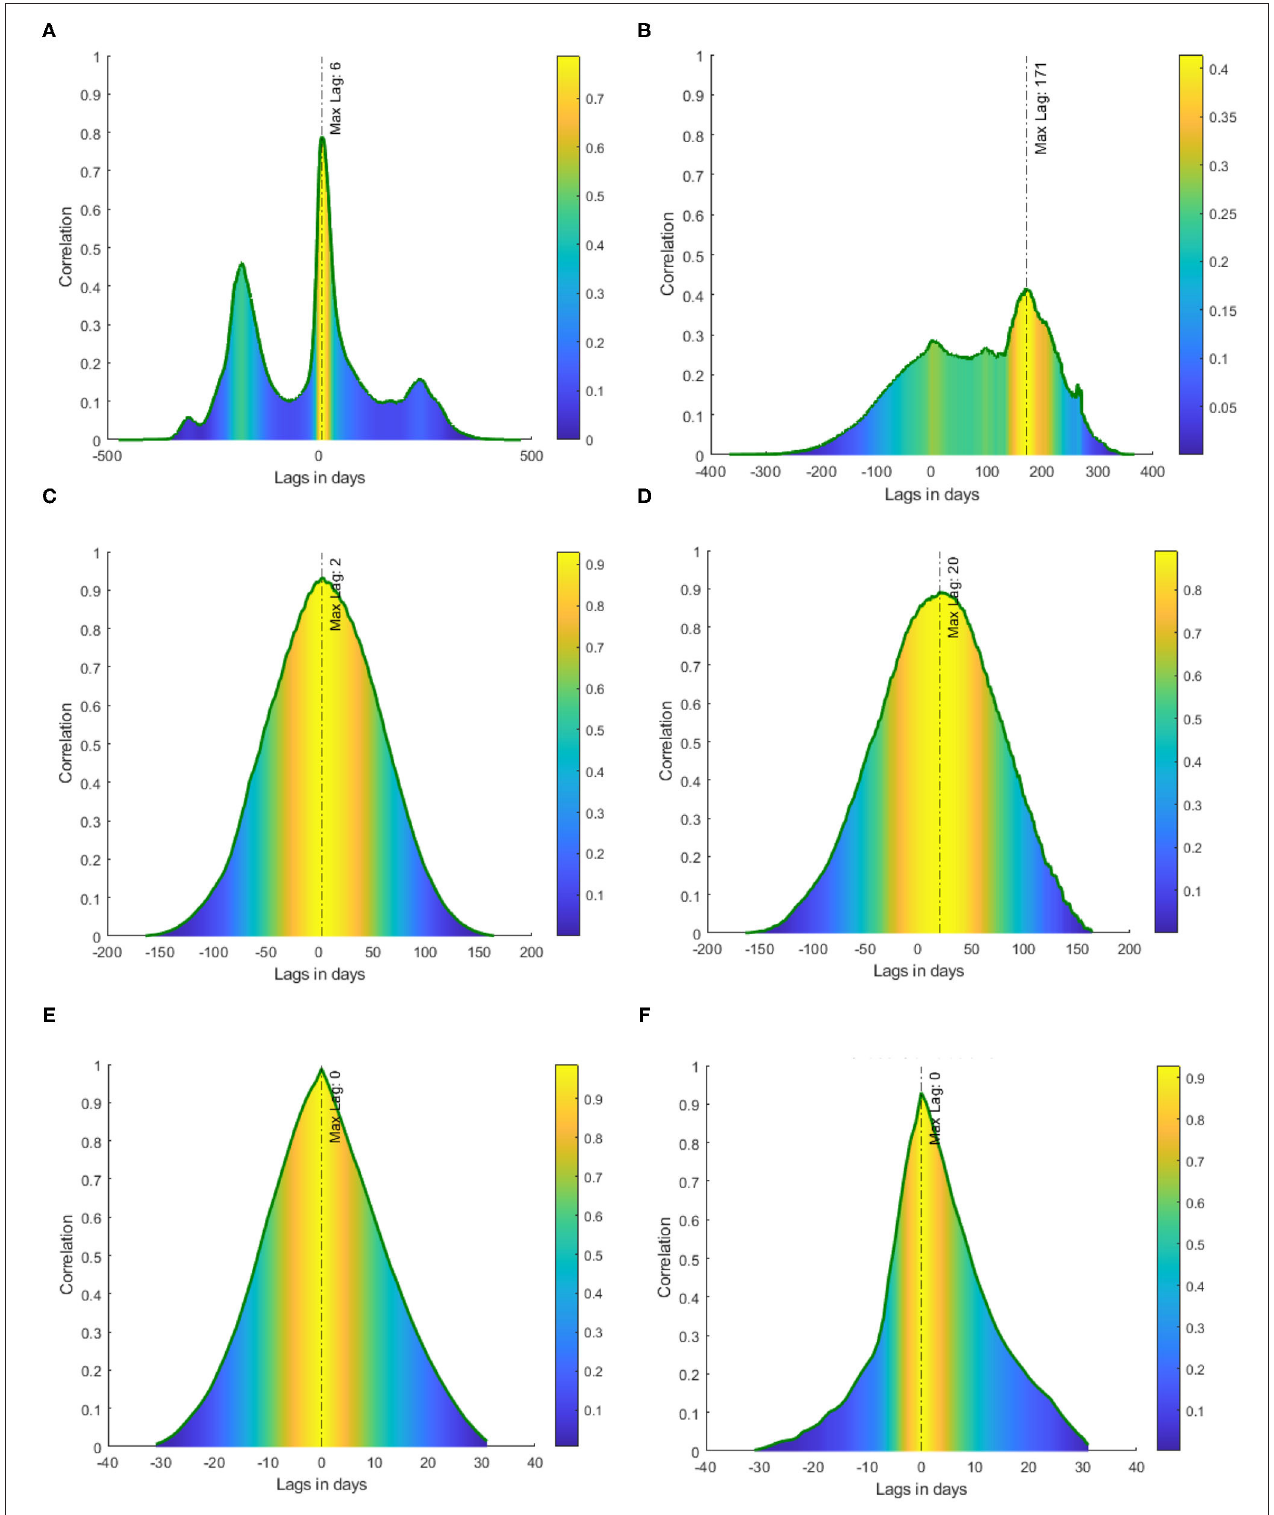
FIGURE 2 | Cross-correlation between Nepal and India with lags in days. The color represents the magnitude of cross-correlation at each lag. (A) Cross-correlation of incident cases, (B) cross-correlation of new deaths, (C) cross-correlation of incident cases in first wave, (D) cross-correlation of daily deaths in the first wave, (E) cross-correlation of incident cases in the second wave, and (F) cross-correlation of daily deaths in the second wave.